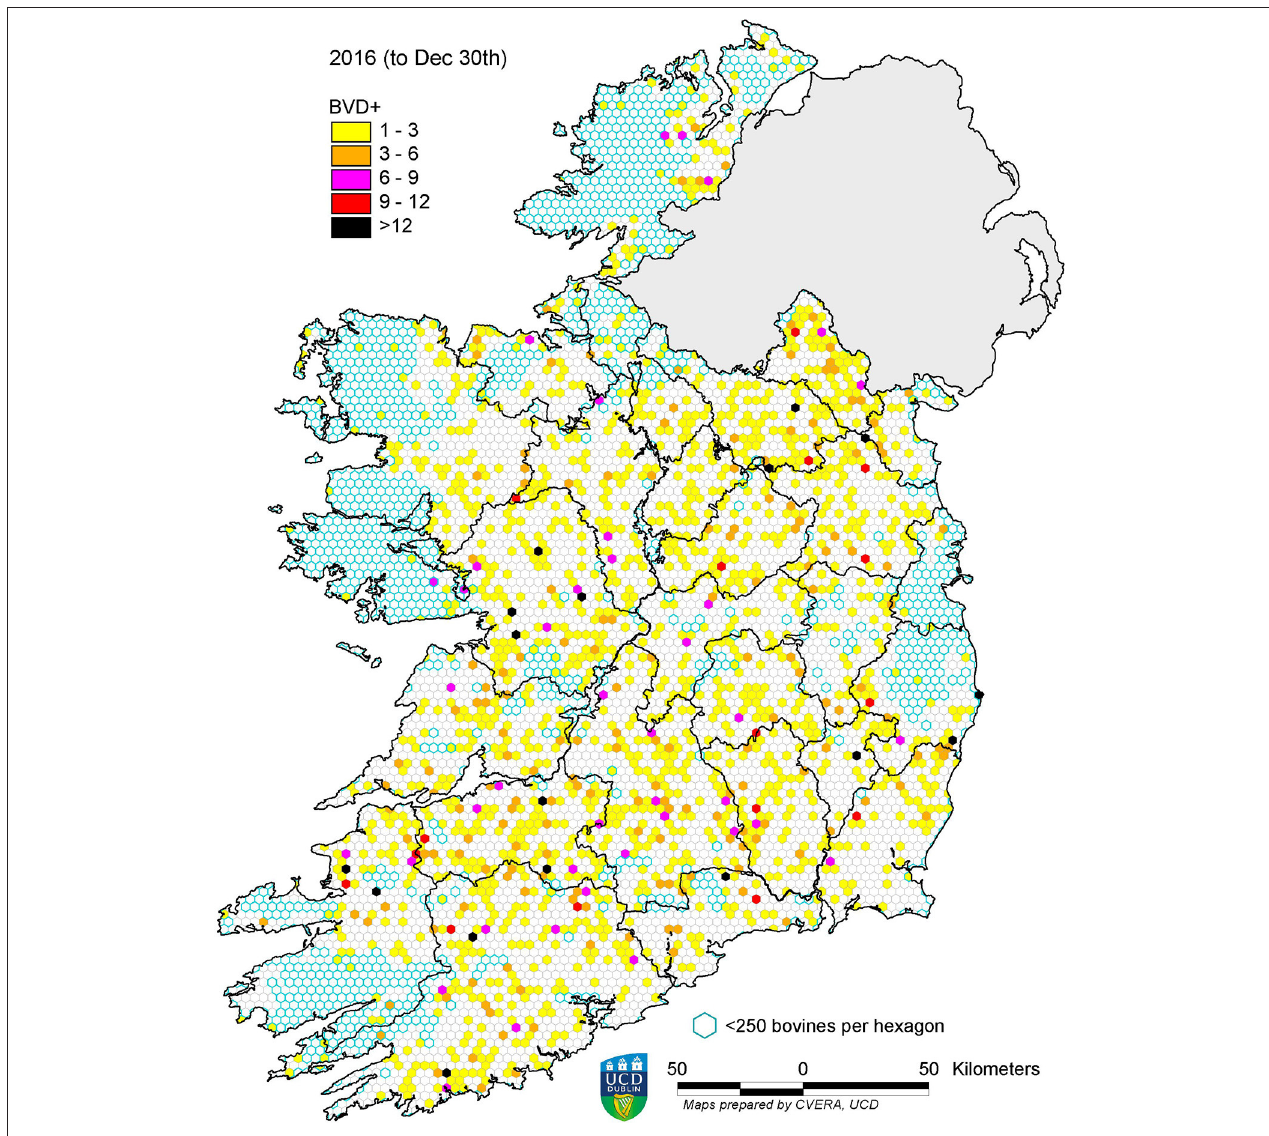
FIGURE 5 | Distribution of BVD + calves born in 2016. Each hexagon ∼ 10 km 2